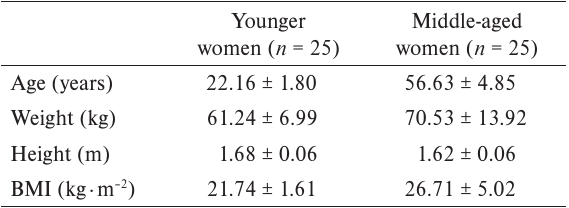
Participants characterisation (mean ±